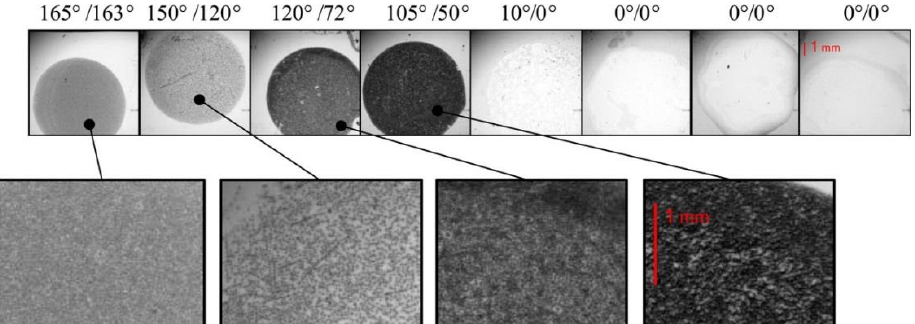
Figure 4. Images of water condensed onto PC samples nano-textured with plasma etching and Plasma-Enhanced Chemical Vapor Deposition (PECVD), coated with different organosilicon-based films. Higher magnification images of the dropwise condensing (fogged) surfaces are shown below. Values of the advancing/receding Water Contact Angle (WCA) are reported at the top. Reproduced with permission from [44]. Copyright 2014 American Chemical Society. fabric [58] and SU-8 photoresist [42].